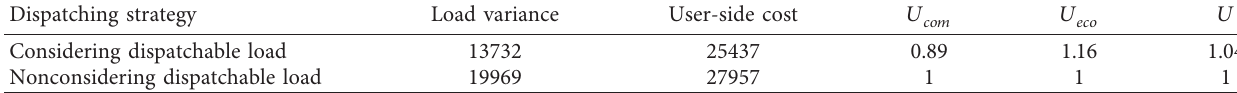
Table 3: Comparison of simulation results of dispatching strategies.